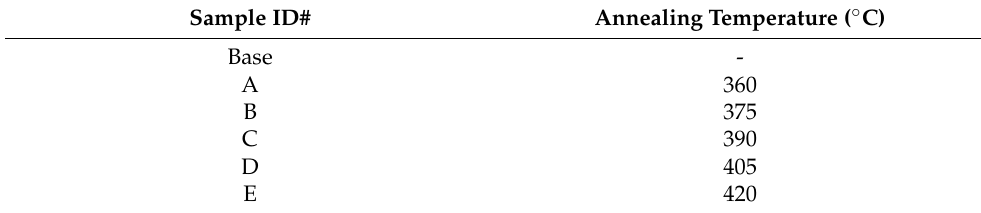
Table 3. Simplified sample name for different annealing